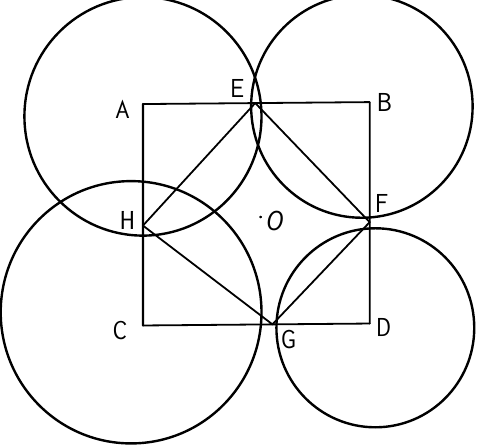
Figure 2. Weighted centroid positioning.